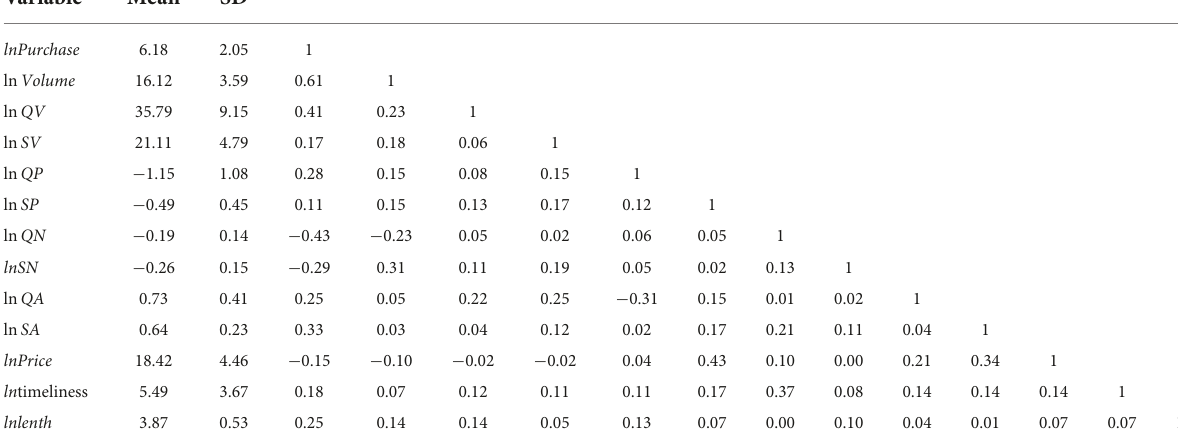
TABLE 3 Summary statistics analysis.